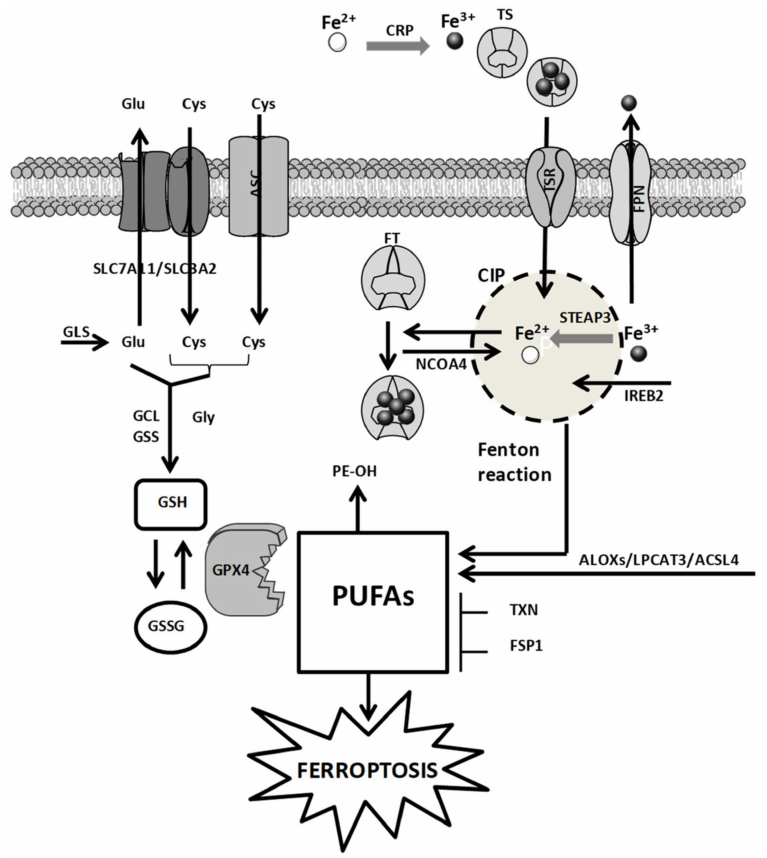
Figure 1. Cellular mechanisms of ferroptosis. The metabolic pathways involving iron, ROS, and amino acids are reported. CIP: cellular iron lipid; FT: ferritin; CRP: ceruloplasmin; TS: transfer- rin; TSR: transferrin receptor; FPN: ferroprotein; ACSL4: acyl-CoA synthetase long-chain family member 4; LPCAT3: lysophosphatidylcholine acyltransferase 3; ALOXs: arachidonate lipoxygenase; GPX4: glutathione peroxidase 4; ASC: alanine–serine–cysteine system; SLC7A11: solute